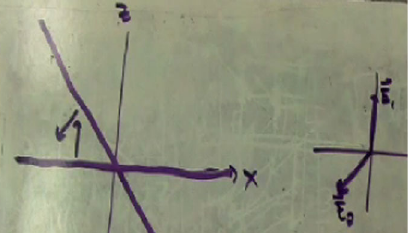
FIG. 9. An example of a student first drawing electric field arrows drawn near or on the lines representing the charged sheets (left), and then (when prompted to perform the addition) placing the electric field arrows tail to tail to find the combined electric field at an arbitrary point